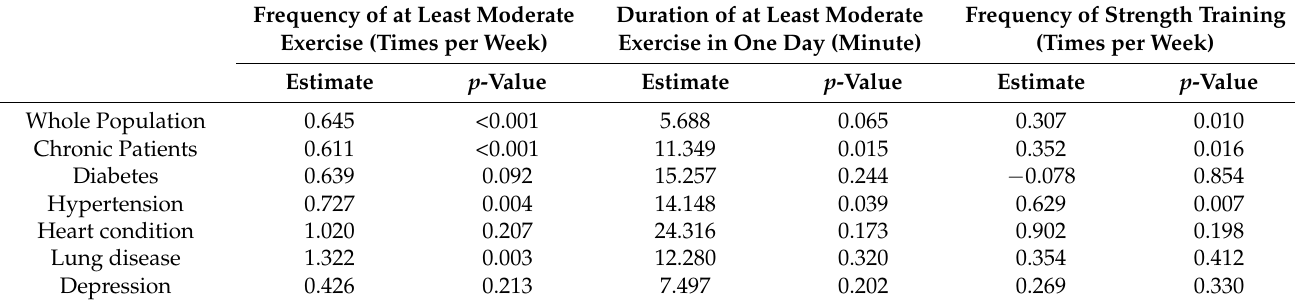
Table 3. Estimation results after matching (taking the frequency of using wearable devices as the independent